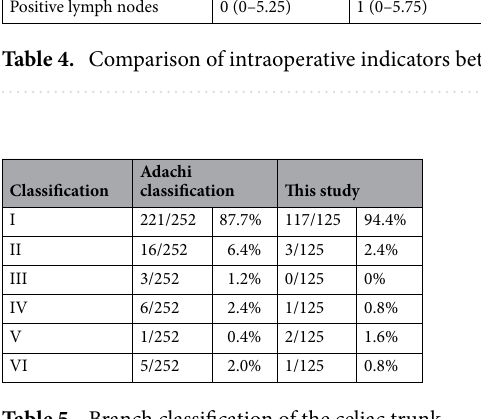
Table 5. Branch classification of the celiac